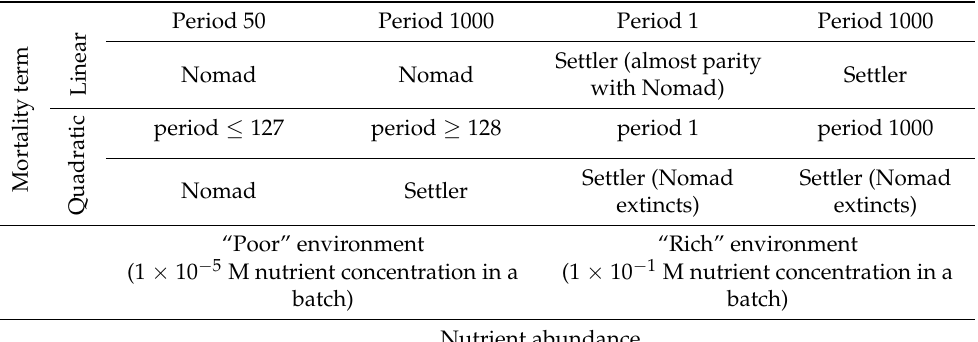
Table 2. Pivot table of the outcomes (who is dominant in the system) for various groups of parameter values. The batch period is measured in